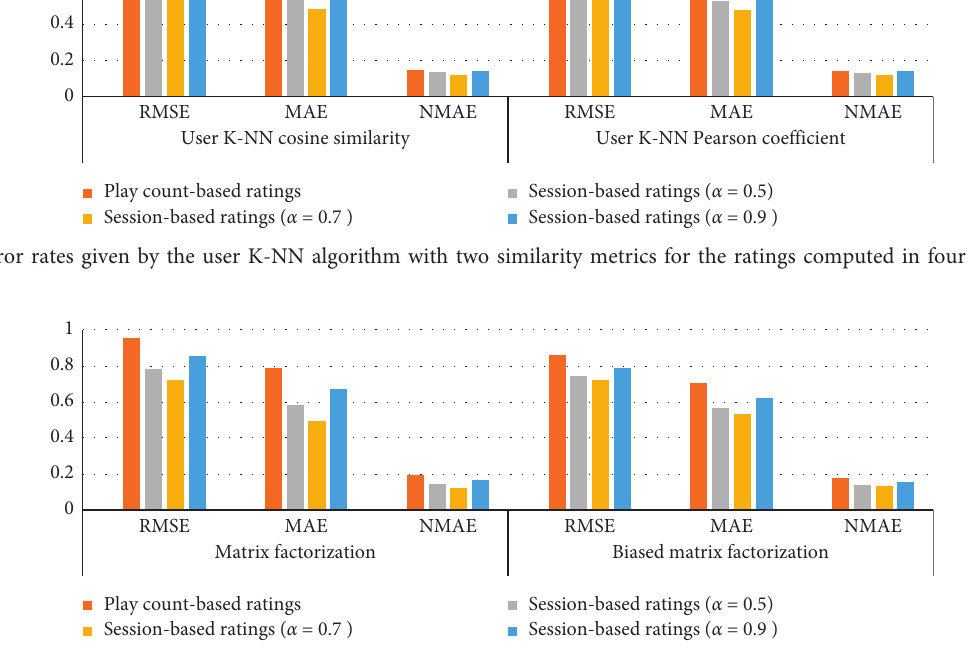
Figure 2: Error rates given by two matrix-factorization methods for the ratings computed in four different